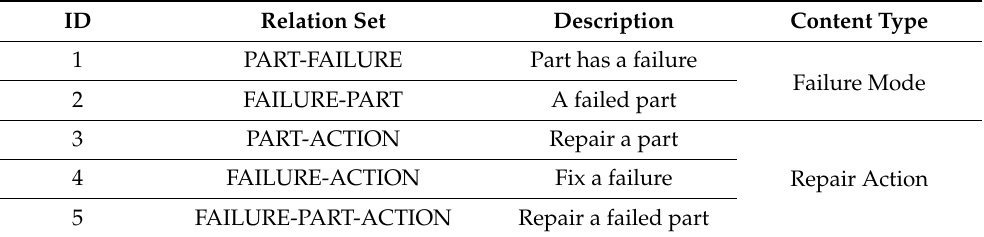
Table 2. Pre-defined relation sets describing failure modes and repair